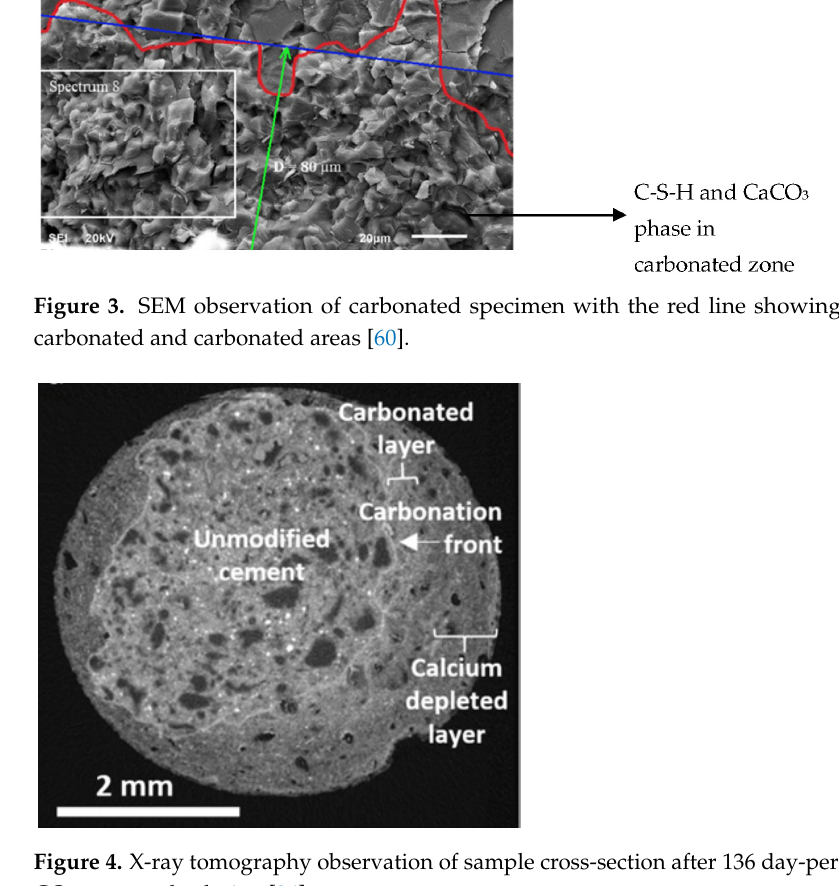
Figure 4. X-ray tomography observation of sample cross-section after 136 day-period of exposure to CO 2 saturated solution [36].